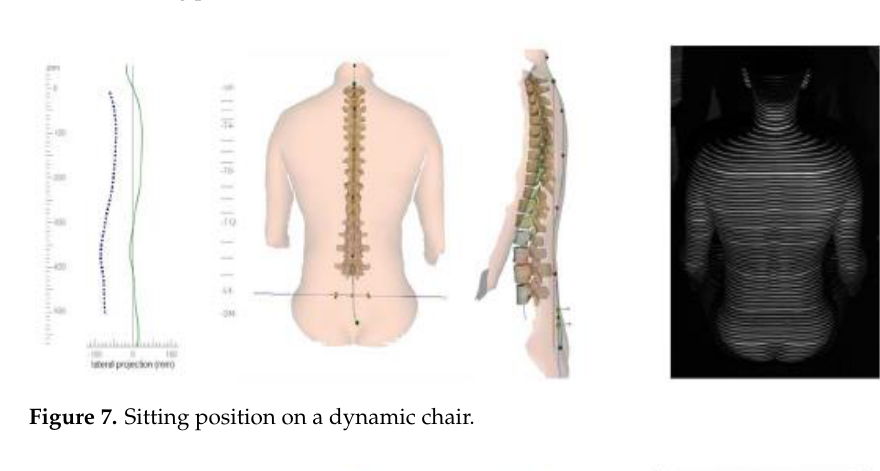
Figure 6. Sitting position on a static chair.